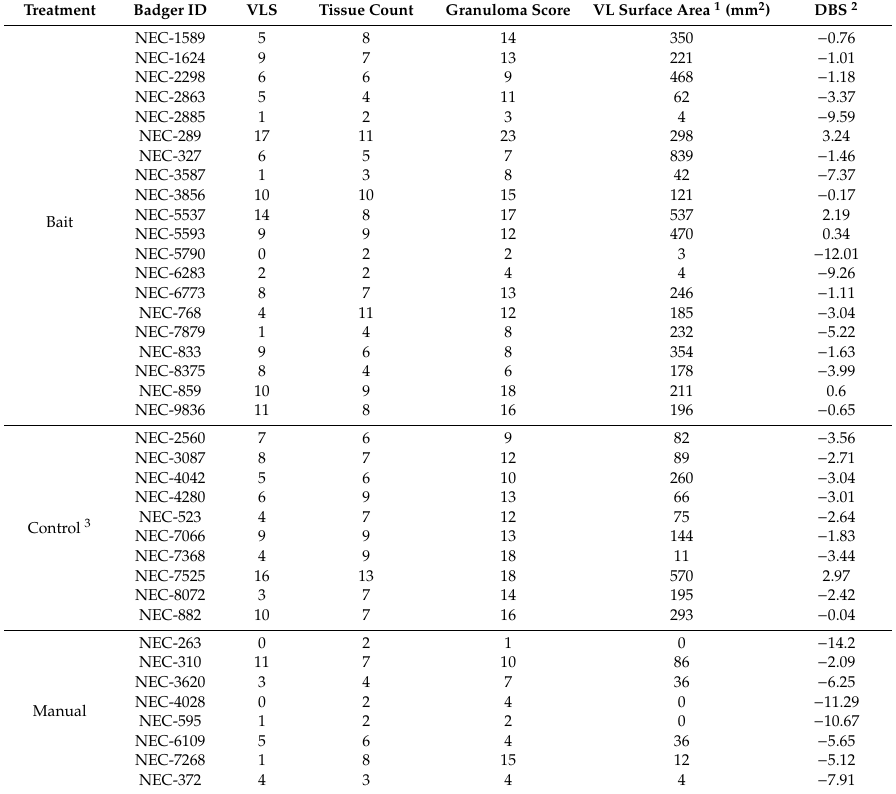
Table 4. Burden of disease for each animal post mortem in VES10, as assessed by four di ff erent measures, as described above.